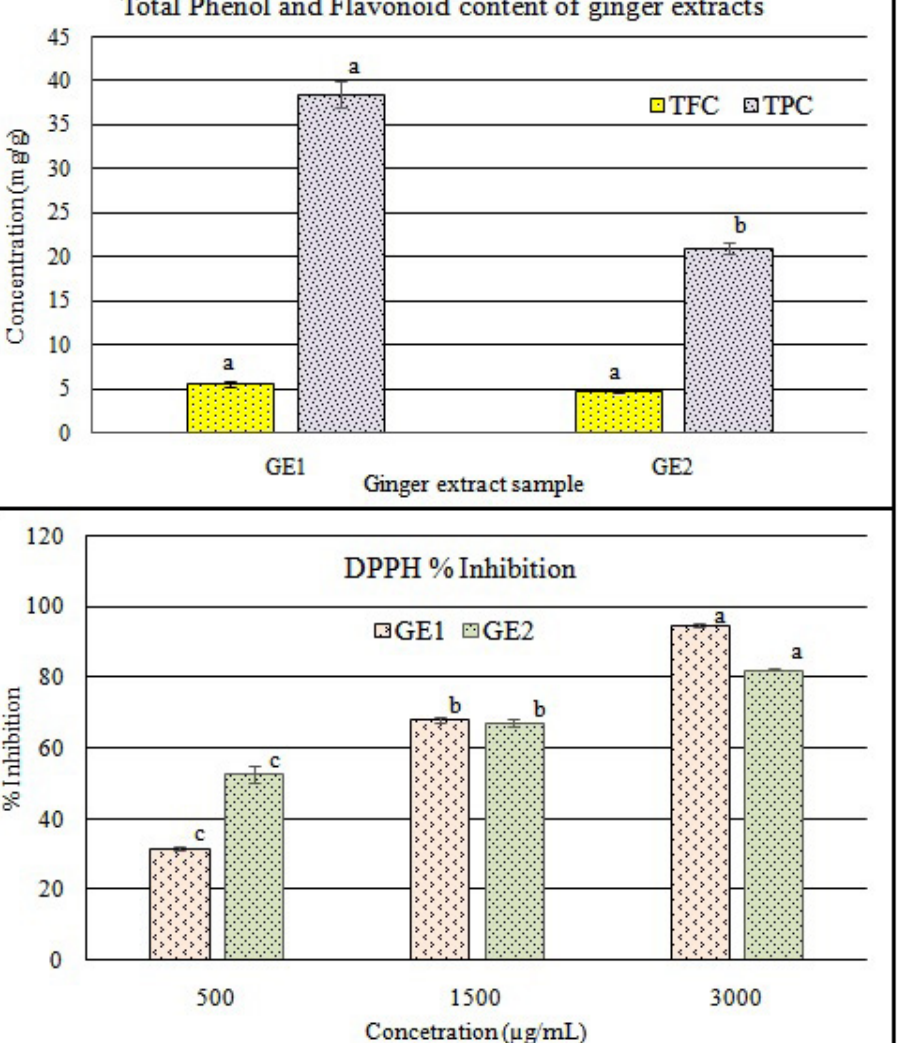
Figure 3: TPC, TFC and DPPH % inhibition activity of ginger extracts extracted by soxhlet (GE1) and SC-CO bars indicates significant difference (p<0.05) while same letters on bars indicates no significant